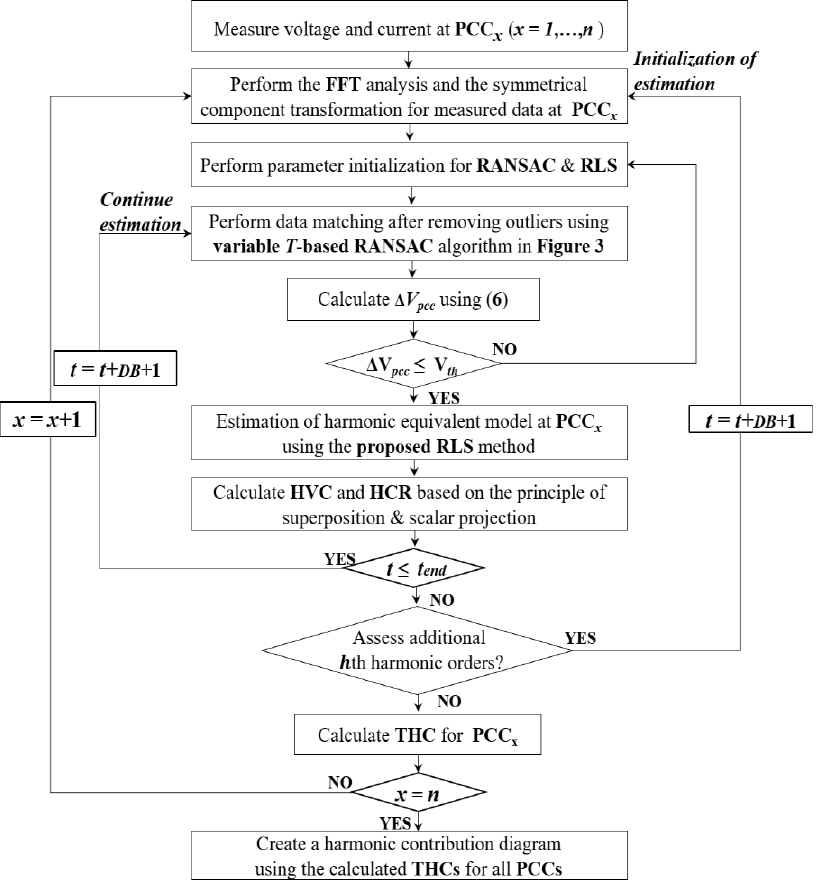
Figure 8. The entire procedure of harmonic contribution assessment based on the proposed method.